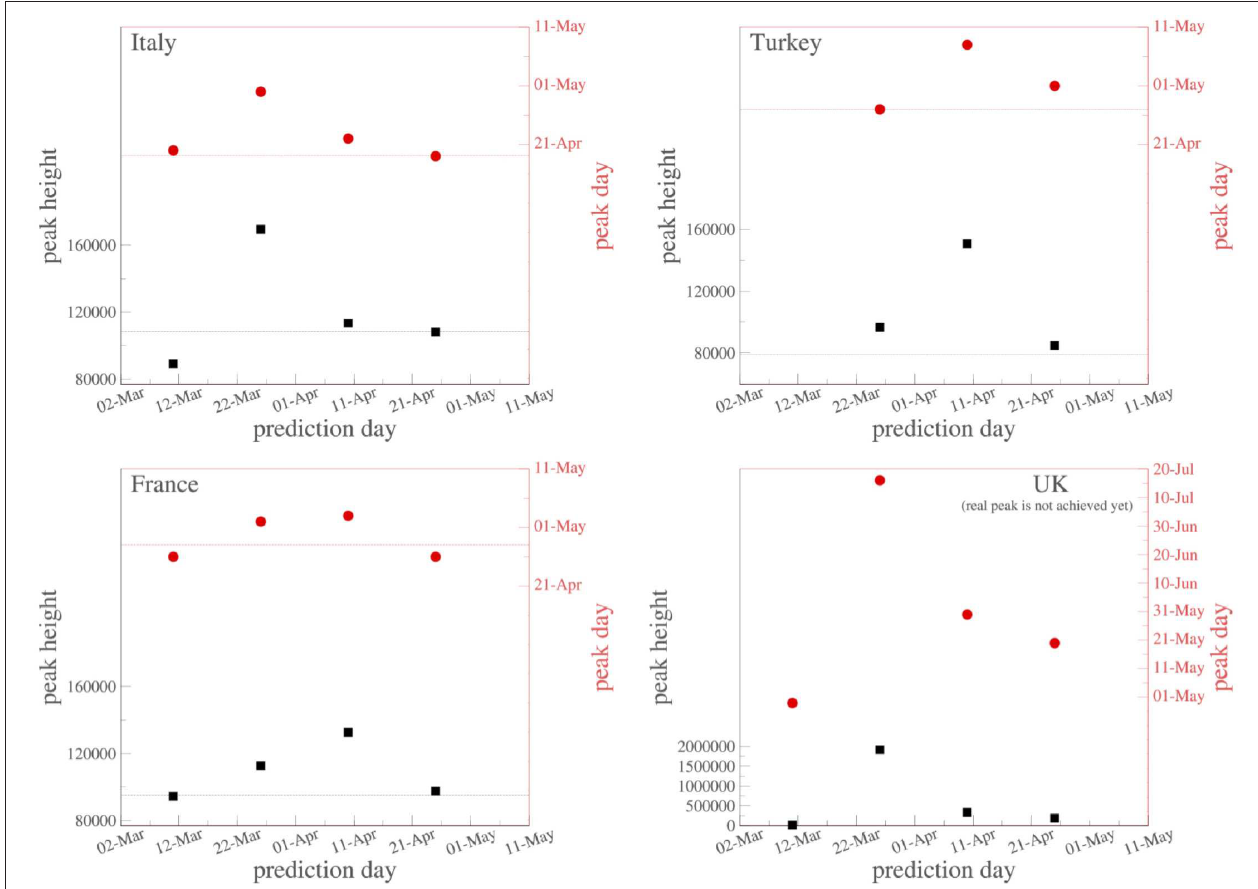
FIGURE 5 | Successive predictions of the date and height of the peak of active cases in Italy, Turkey, France, and the United Kingdom using gradually updated data. The red (black) dashed line indicates, for Italy, Turkey, and France, the currently known real values for the peak date (height). The peak has not yet been achieved in the United